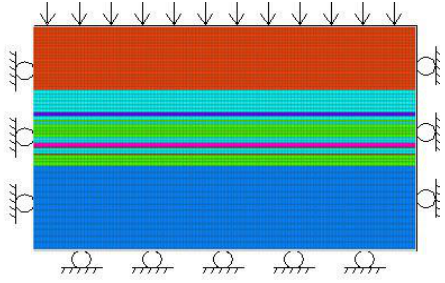
Figure 5. Boundary condition of model.